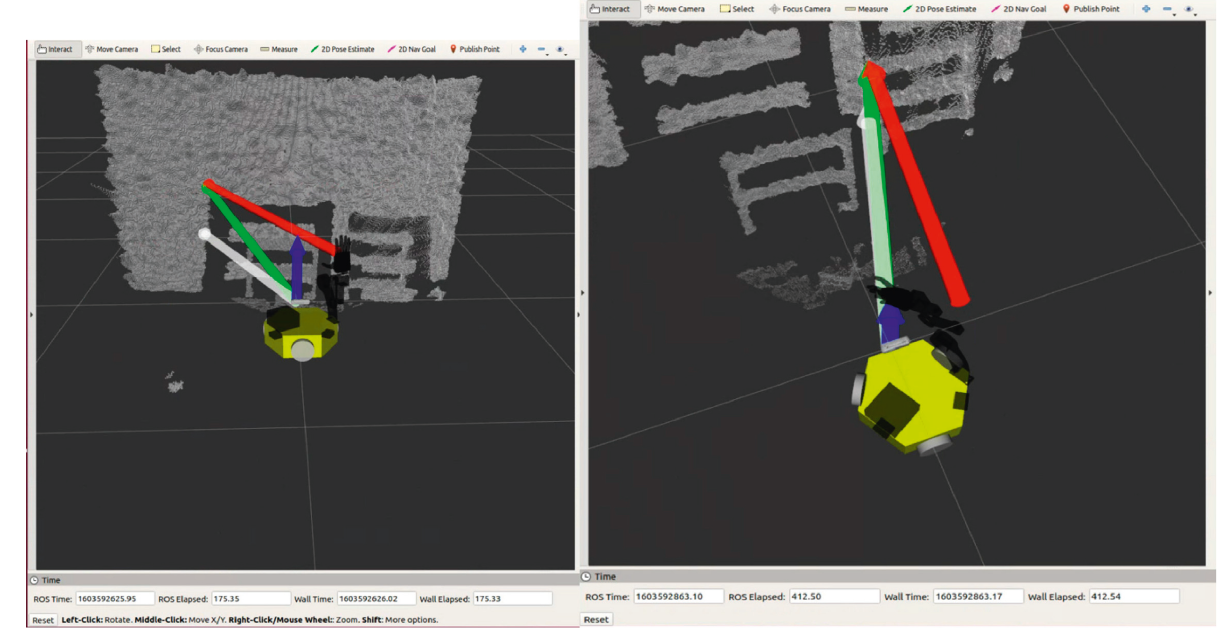
Figure 19: Sample point selected and associated visual markers.